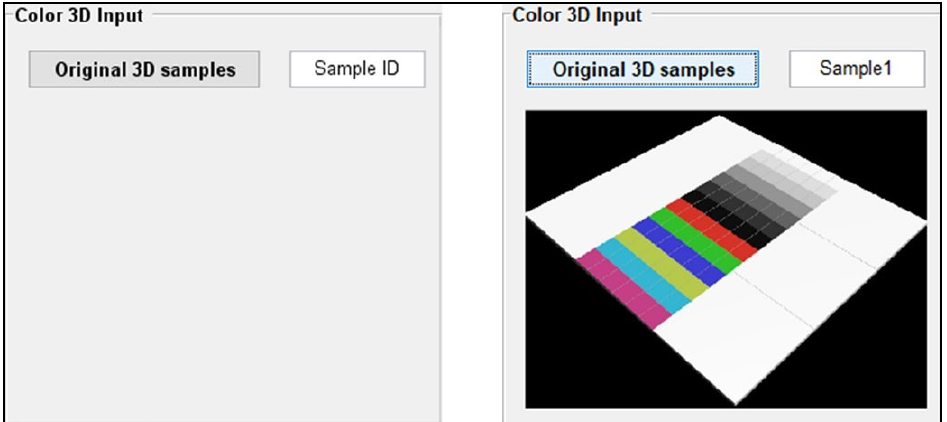
Figure 10. Initial interface and sample demonstration of Module 1. Table 1. Types, labels, and roles of controls used in the Module 1 interface. Table 1. Types, labels, and roles of controls used in the Module 1